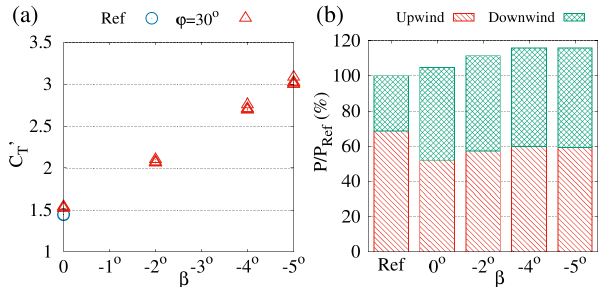
Figure 4. Effect of enforcing negative rotor-collective blade-pitch angles β on upwind-row turbines tilted by ϕ = 30 ◦ . (a) Temporally averaged local thrust coefficient C (cid:48) of the individual turbines of the T upwind row. (b) Wind power extracted by the upwind (hatched red) and downwind (cross-hatched green) rows of turbines normalized by the total power P Ref produced in the baseline case (Ref).